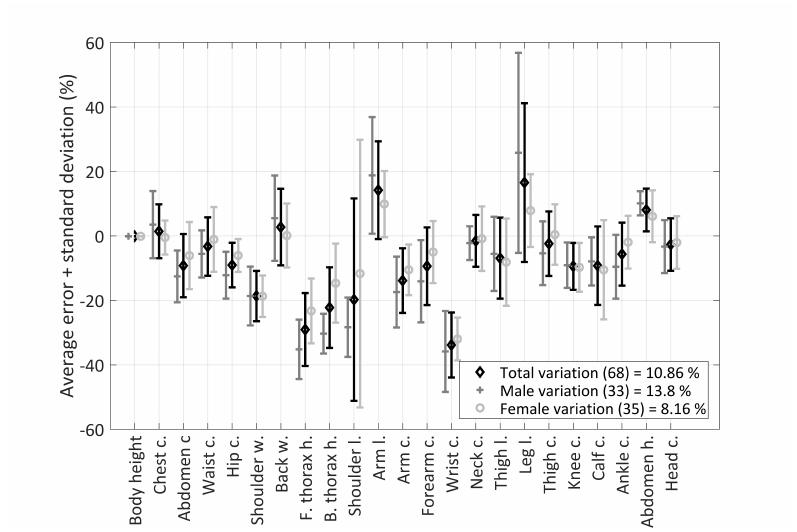
Figure 7. Chinese adults. Average variations and the standard deviations.